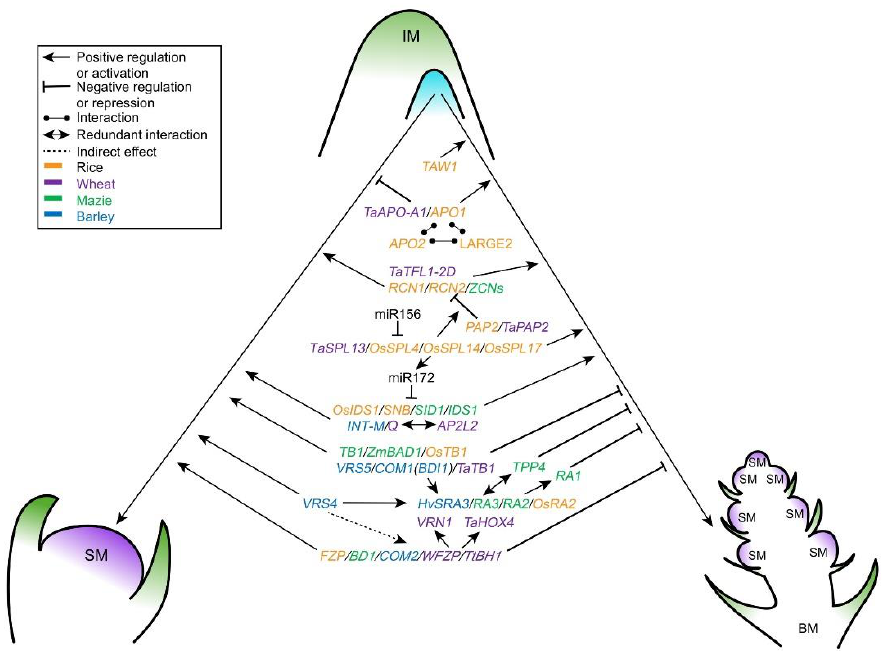
Figure 3. Genetic regulation of IM differentiation in cereal crops. The multiple players, including MADS, TCP, AP2 and SPL transcription factors, RA proteins, miRNAs, and their crosstalk genet- ically control BMs or SM identity in rice, maize, wheat and barley. IM, inflorescence meristem; BM, branch meristem; SM, spikelet